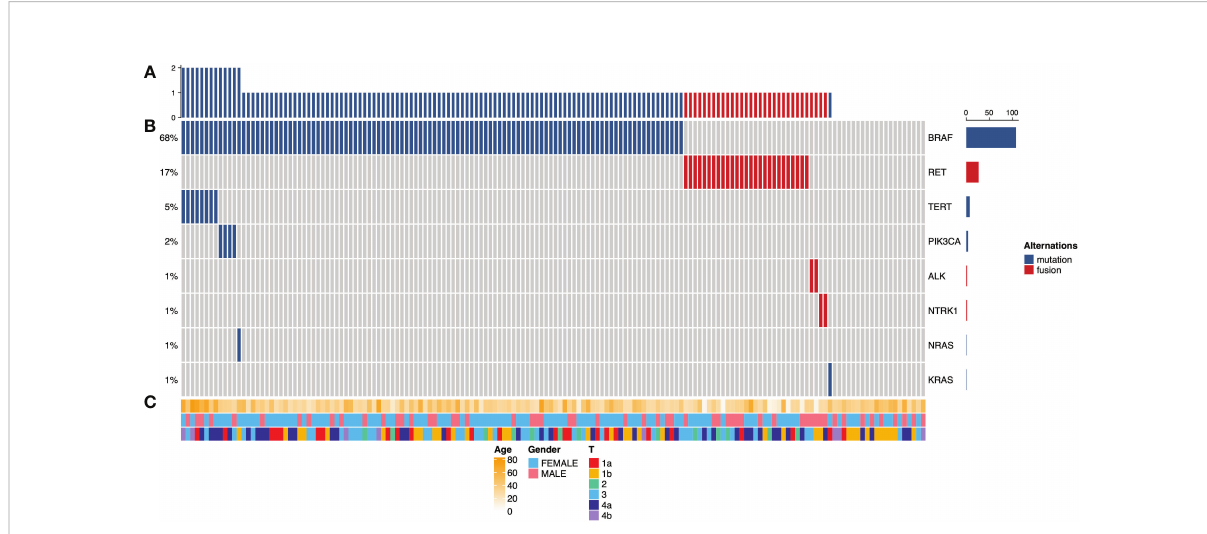
FIGURE 1 Cancer genome alterations in 160 papillary thyroid carcinomas with lateral lymph node metastasis. (A) Mutation density across the PTC with lateral lymph node metastasis cohorts (n = 160), expressed as a number of genetic alterations found in 57 known thyroid-cancer-related genes. (B) Oncoprints of PTC with LLNM. The left side shows the percentage of tumors altered for each event; the Color key for genetic alterations is shown in the right panel. (C) Clinicopathological features, including patients ’ age, gender, and tumor stage. Color keys are shown in the bottom